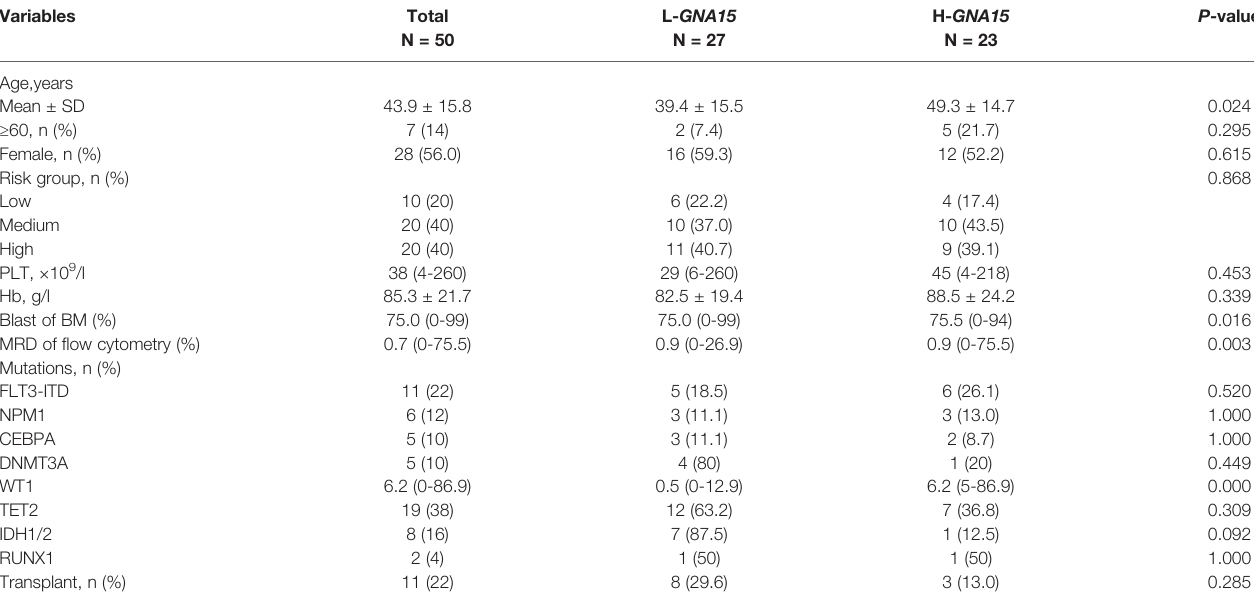
TABLE 1 | Relationship between Transcription Level of GNA15 and Clinical Characteristics in Normal Karyotype AML.